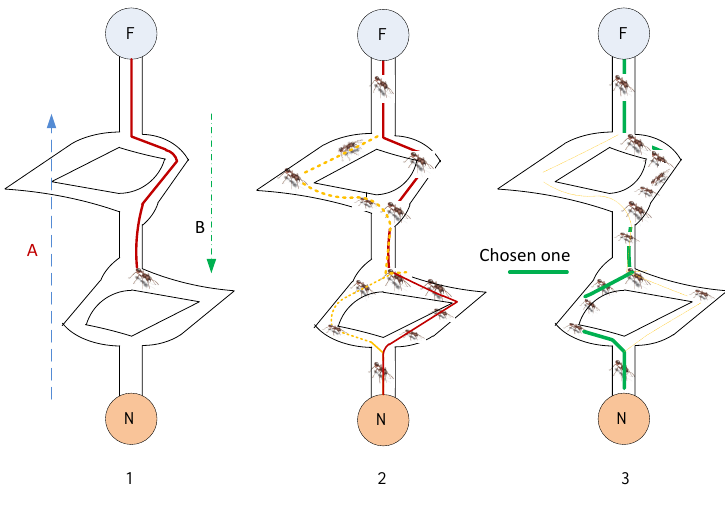
Figure 6. Ants follow the minimal path from nest to food